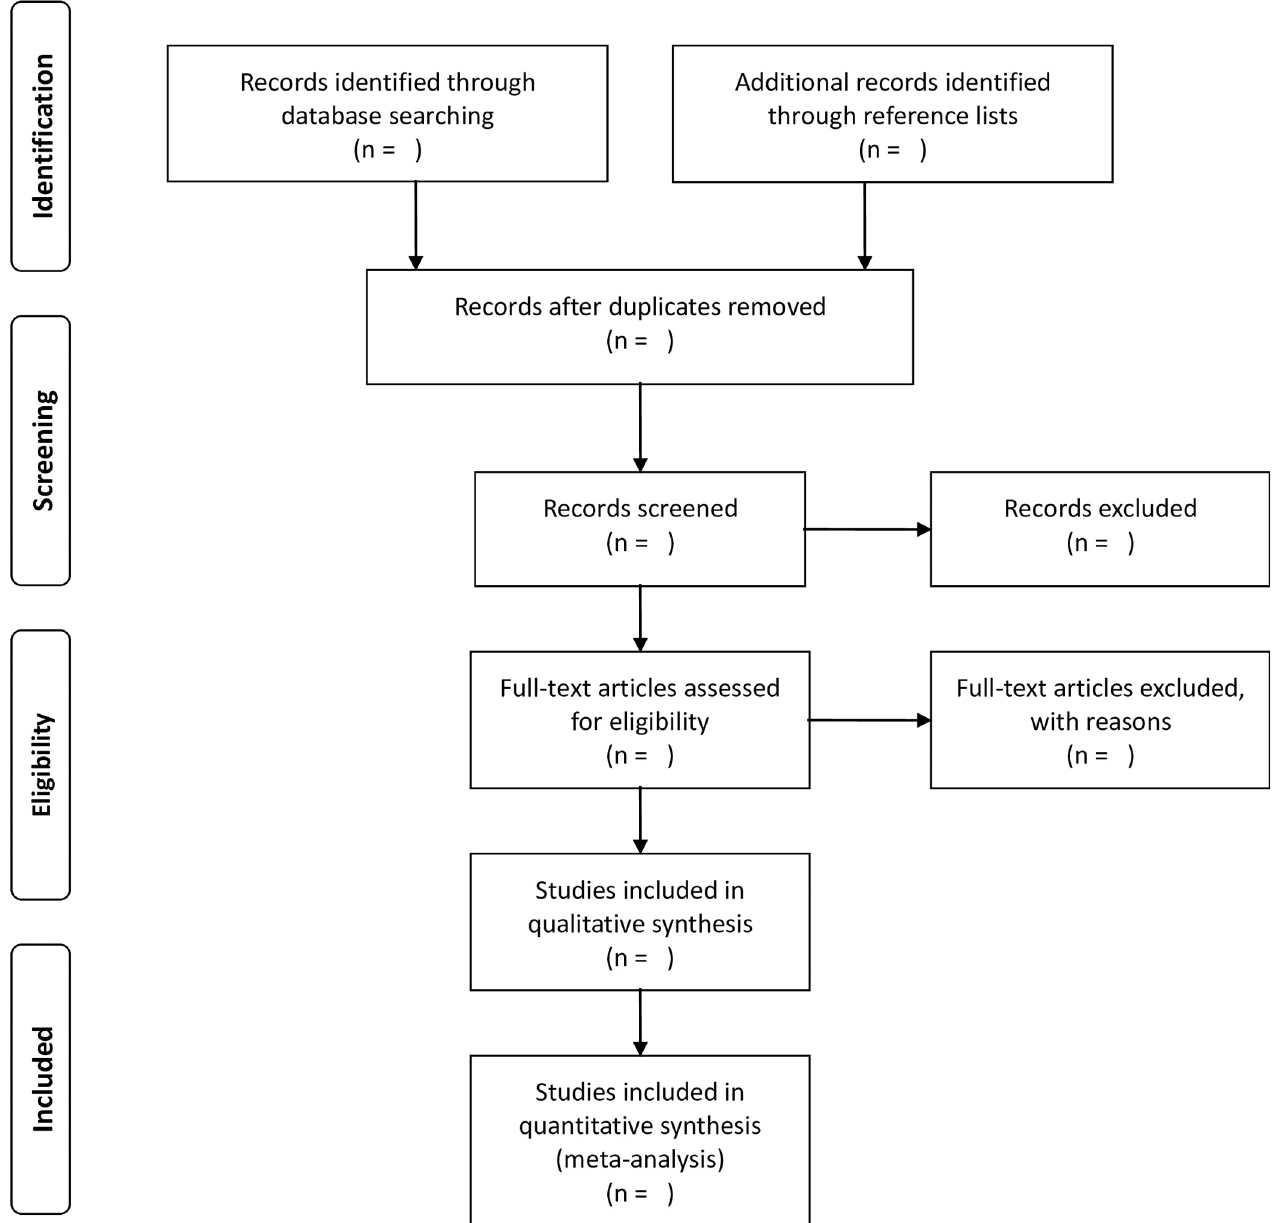
Fig 1. PRISMA flow